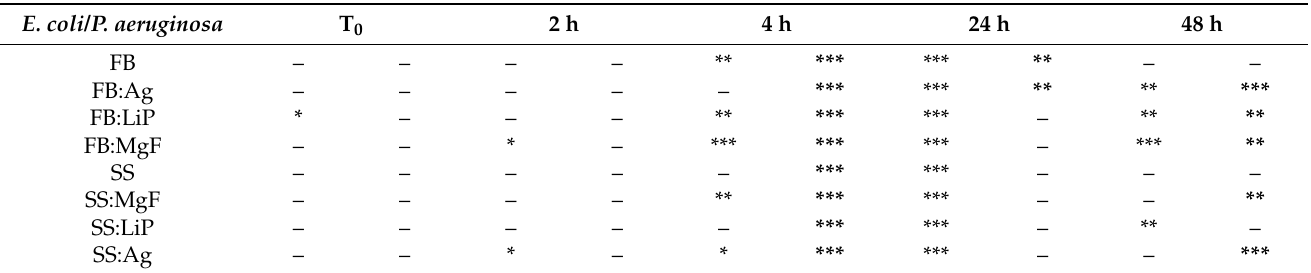
all of the tested materials, had significantly decreased the logCFU/mL, while at 48 h, the antibacterial protection had been reduced, with a significant decrease in viable cells noticed for FB:MgF, FB:Ag, FB:LiP, and SS:LiP (Table 4, Figure S5). Table 4. Representation of the statistically significant inhibitory effect exhibited by different samples against the adherence and growth of E. coli and P. aeruginosa (in bold ) at different incubation times